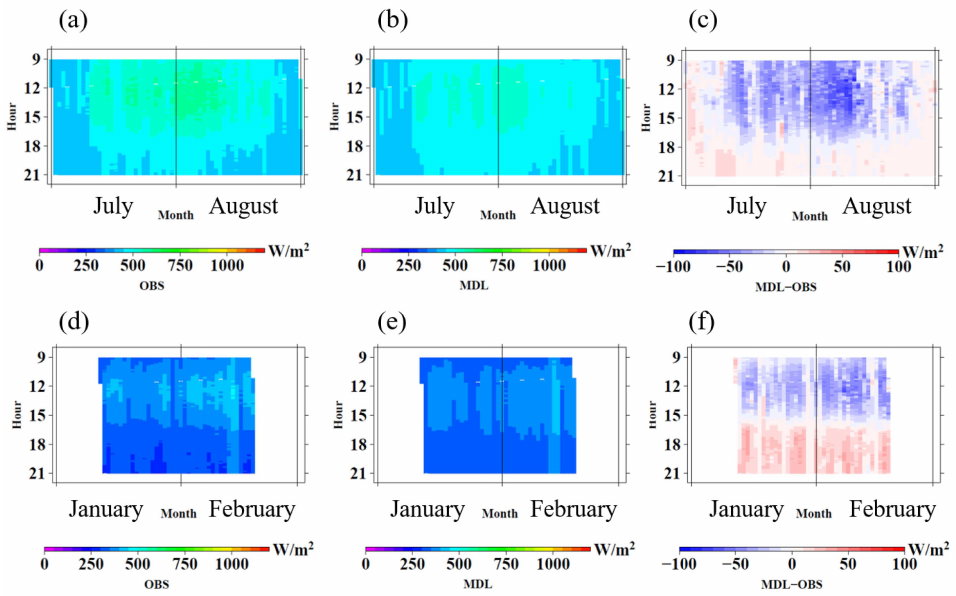
Figure 10. Time cross-sections of ( a ) ULW observations at the Tsukuba station (OBS), ( b ) dx500m forecasts (MDL) with 00 UTC (09 JST) initialization time, and ( c ) the di ff erence ( = MDL − OBS) for the Exp-Summer in 2015 (top panels) and the Exp-Winter in 2016 (bottom